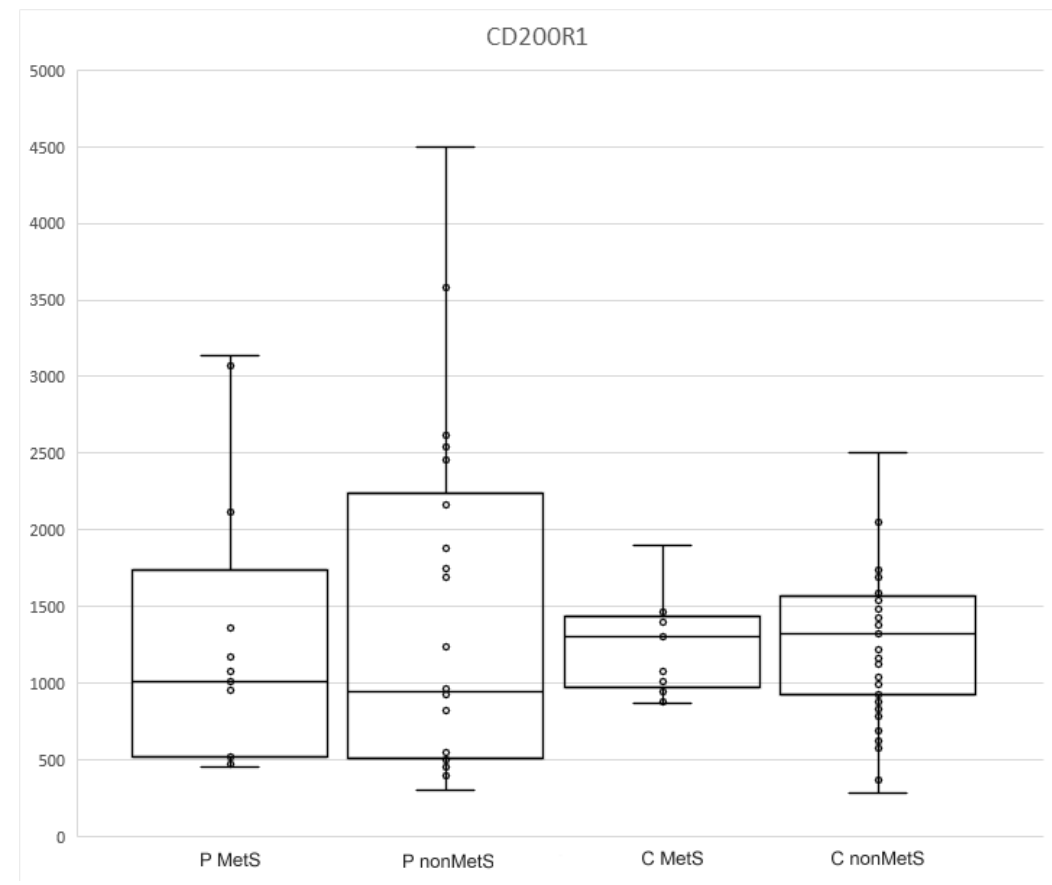
Figure 2. The levels of sCD200R1 in MetS and nonMets patients and controls.